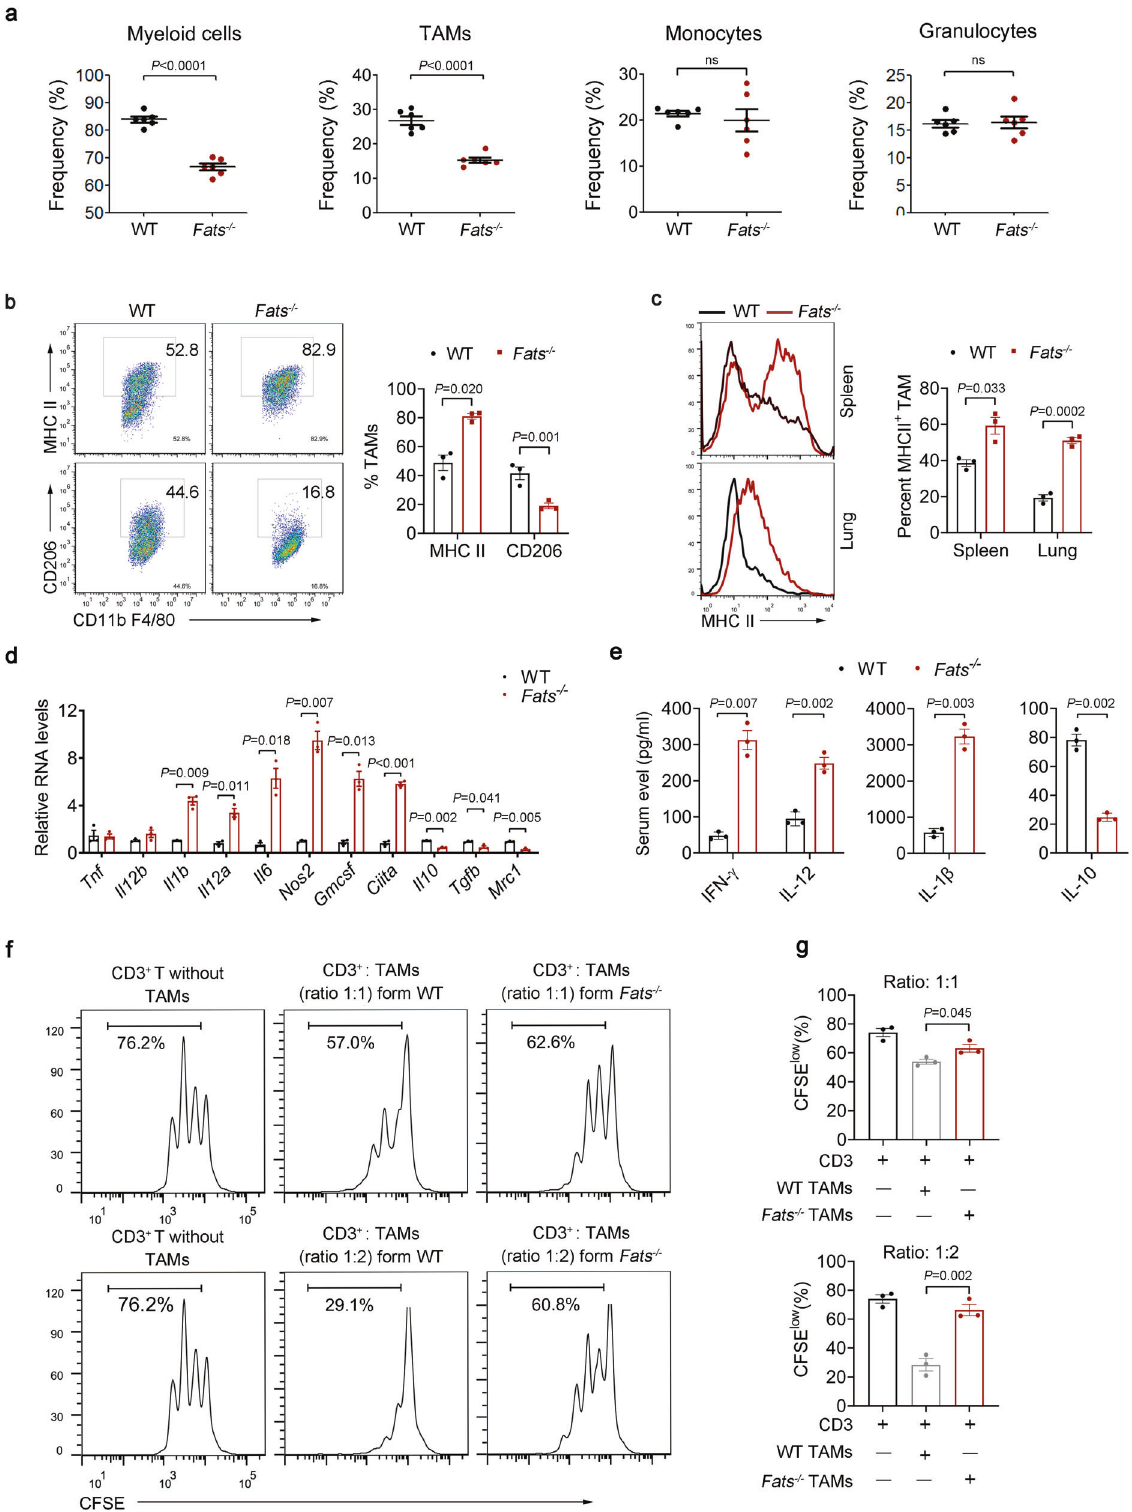
analyzed in vitro in primary mouse macrophages stimulated with lipopolysaccharide (LPS) or IL-4. The expression of proin- fl ammatory cytokines that are associated with M1 macrophages was upregulated in Fats − / − BMDMs. In contrast, the expression of genes associated with M2 macrophages ( Arg1 and Ym1 ) was inhibited (Fig. 4b, c and Supplementary Fig. 3a – c). Similar